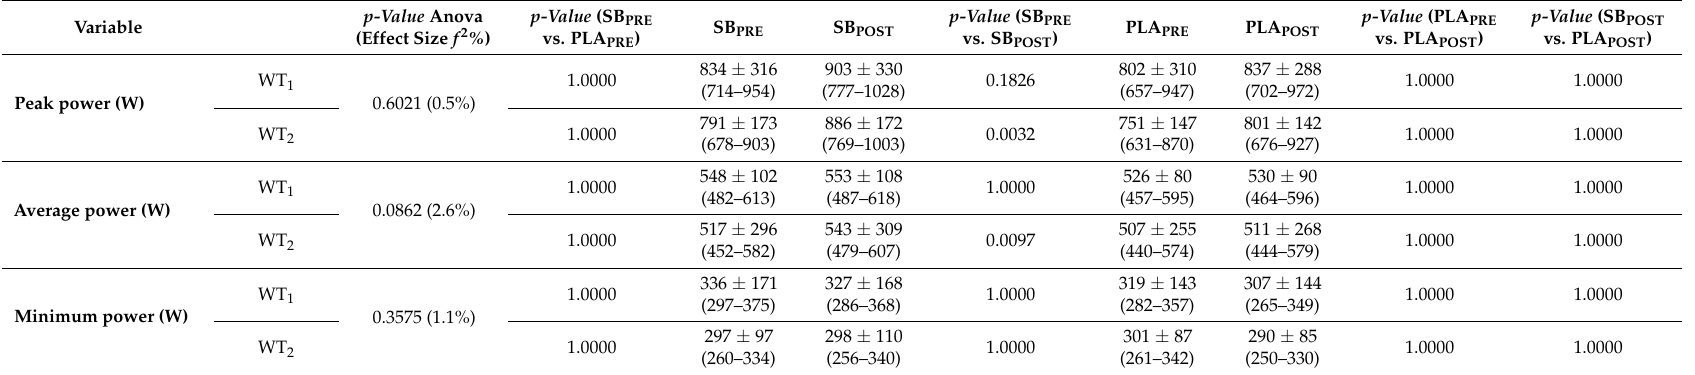
Table 3. Power Indices in the Wingate Anaerobic Test.